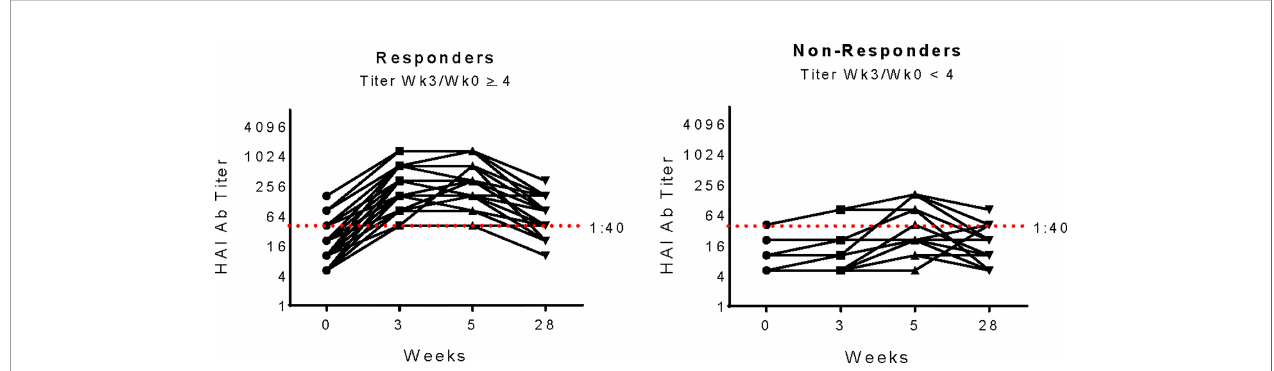
FIGURE 1 | pH1N1 Serology for Study participants. pH1N1 Ab titers as determined by Hemagluttination Inhibition Assay (HAI) in study participants from Responder and Non-responder groups at each timepoint in the IMPAACT P1088 study. Responders (n=29, left panel) were de fi ned as exhibiting a 4-fold increase at week 3 compared to week 0 and Non-responders (n=11right panel) failed to increase titers at least 4-fold between week 0 and 3. The red dashed line at titer 1:40 shows the accepted threshold for